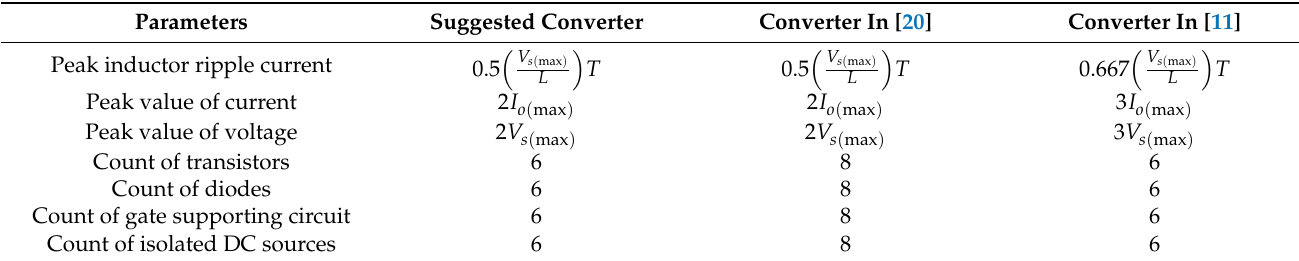
Table 2. Comparison of the performance evaluation for inverting voltage step-up output considering a factor of